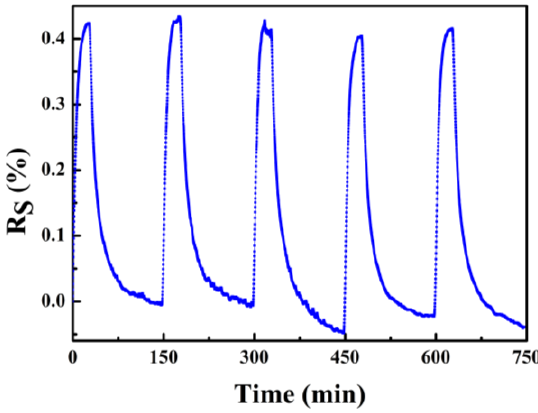
Figure 10. Five cycles of the PdNi film resistor under 3% H 2 concentration.